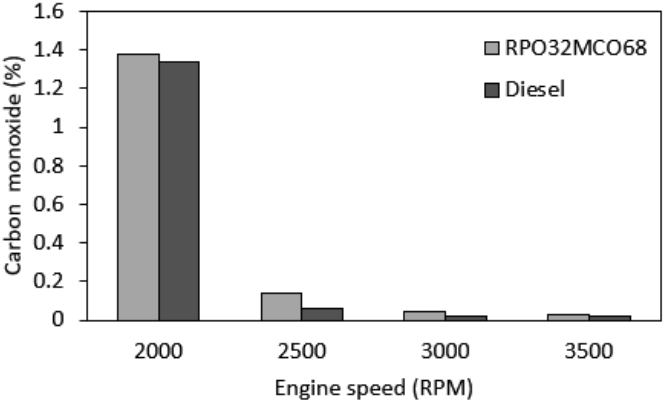
Figure 14. Comparison of carbon monoxide emission as a function of engine speeds.